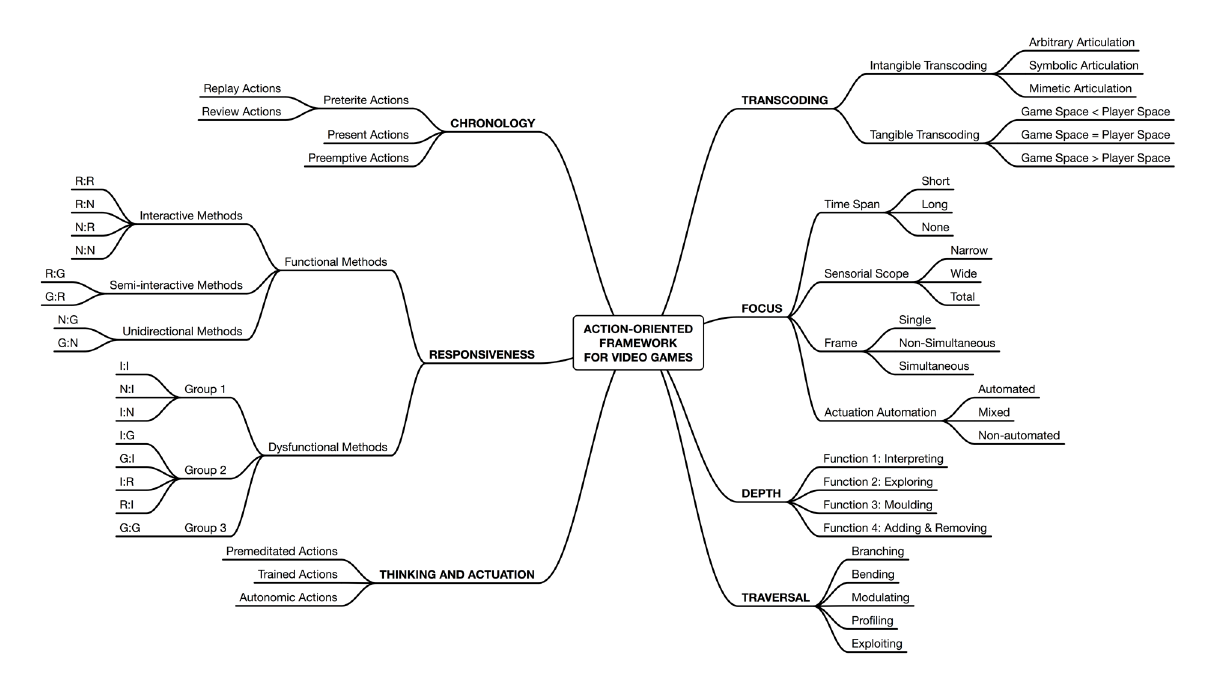
Figure 2 | Overview of the seven dimensions featuring all the